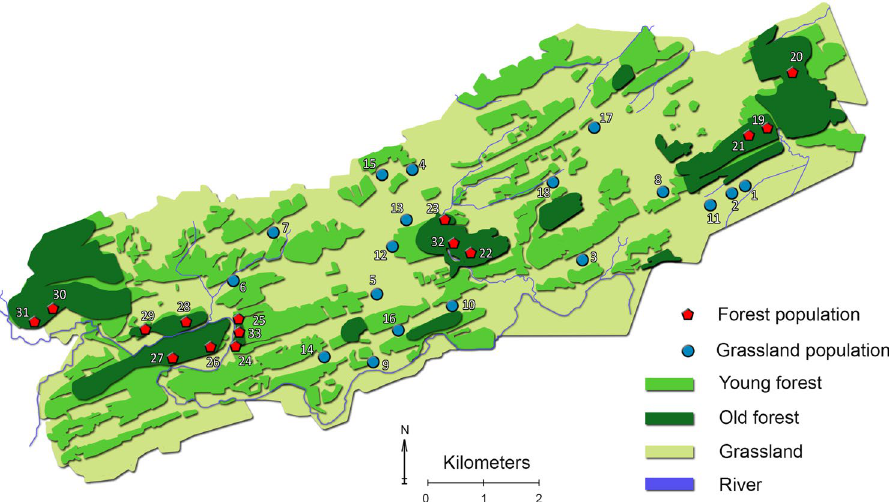
Figure 5. Map of the study area with forest populations indicated by red pentagons and grassland populations by blue circles. Old forest are forests that were present at least from 1775 until today. Map modified with